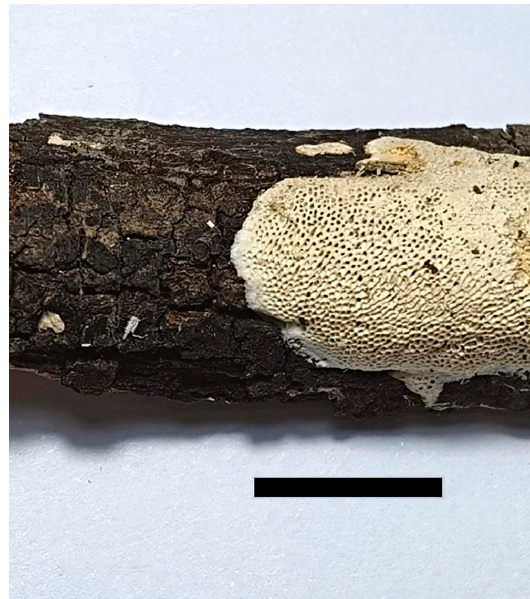
Figure 7. Basidiocarp of Haploporus punctatus (Holotype). Scale bar = 1.0 cm.